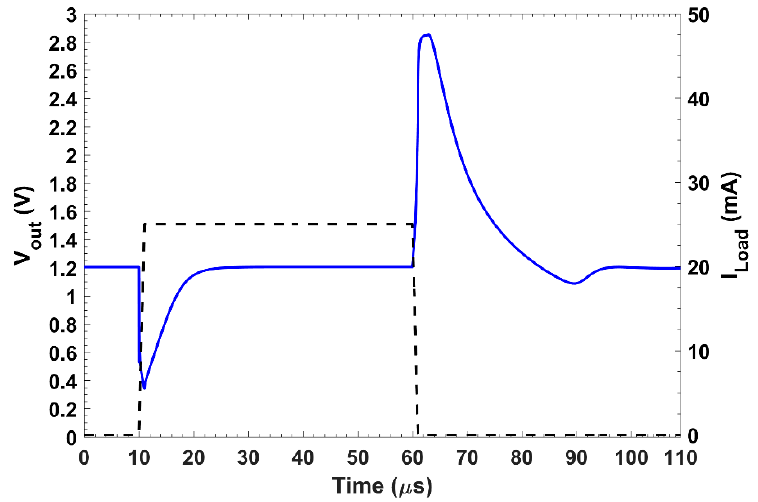
Figure 5. Load transient behavior, from 0 to 50 mA, w/o transient enhancement with V BAT = 3.3